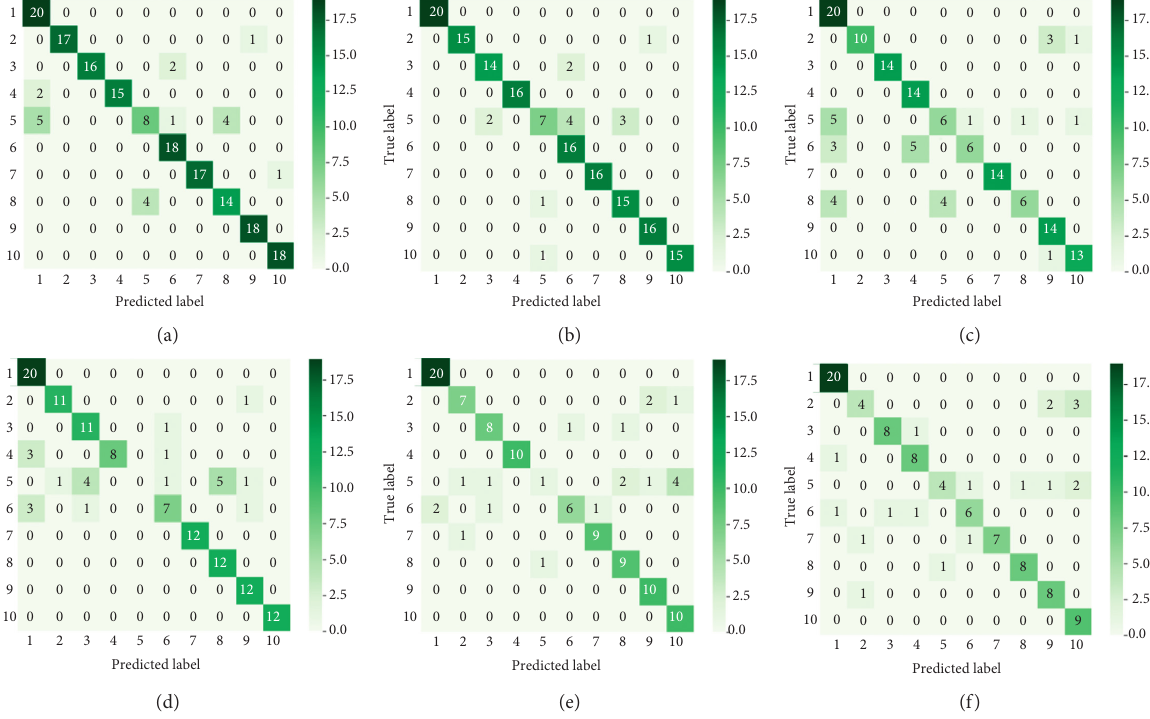
Figure 11: Confusion matrices of GCNN for the ten-classes scenario in different cases. (a) Case 2. (b) Case 3. (c) Case 4. (d) Case 5. (e) Case 6. (f) Case